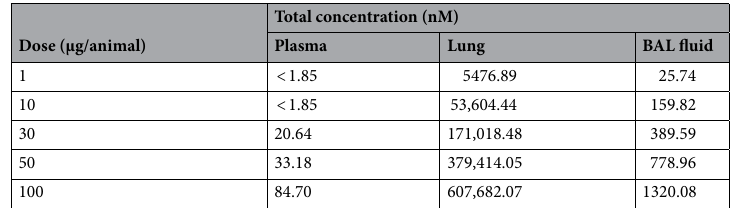
Table 2. Concentrations of PCCR-1 observed in mice exposed to cigarette smoke at 1 µg, 10 µg, 30 µg, 50 µg and 100 µg on day-8 after intranasal dose of PCCR-1.